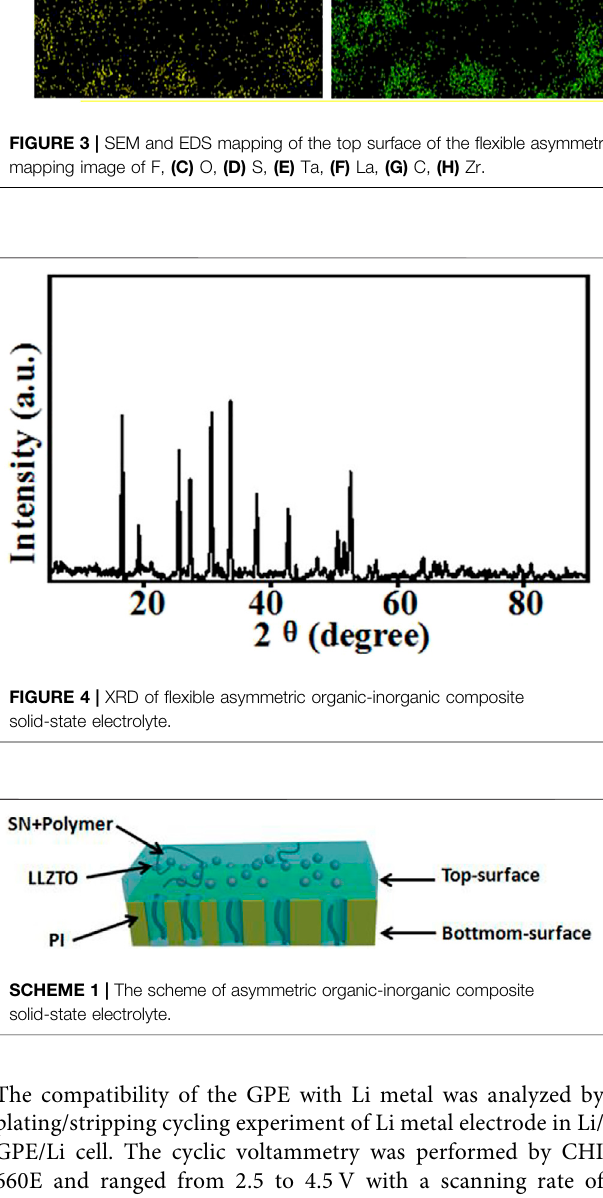
Frontiers in Chemistry |